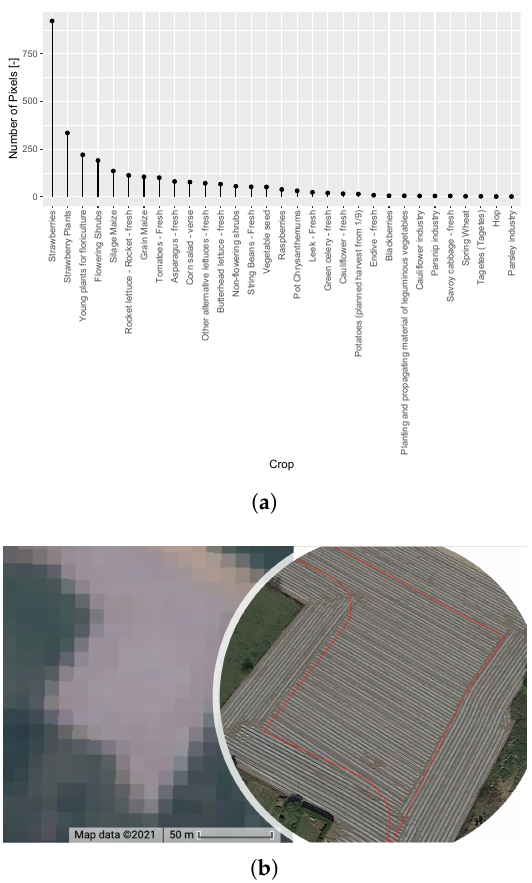
Figure 10. Illustrating covered pixels detected with either GVI1 or GVI2 < 0. ( a ) Planned crops of pixels with GVI1 or GVI2 < 0 corresponding to diverse artificial soil covers. ( b ) An example of a parcel with GVI1 < 0 planned for maize (as per the IACS database). The parcel is covered with plastic mulch film stripes as viewed by Sentinel-2 (left) and high resolution imagery (right); the red polygon indicates the buffered